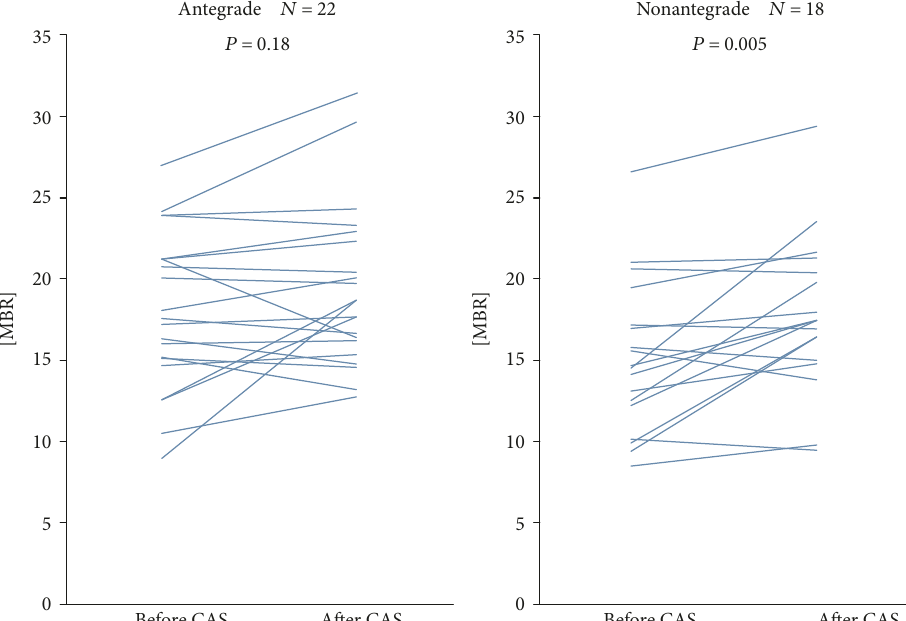
Figure 6: Change in the MBR before and after CAS in the antegrade and nonantegrade groups. There was the signi fi cant rise in the MBR in the nonantegrade group ( P = 0 005